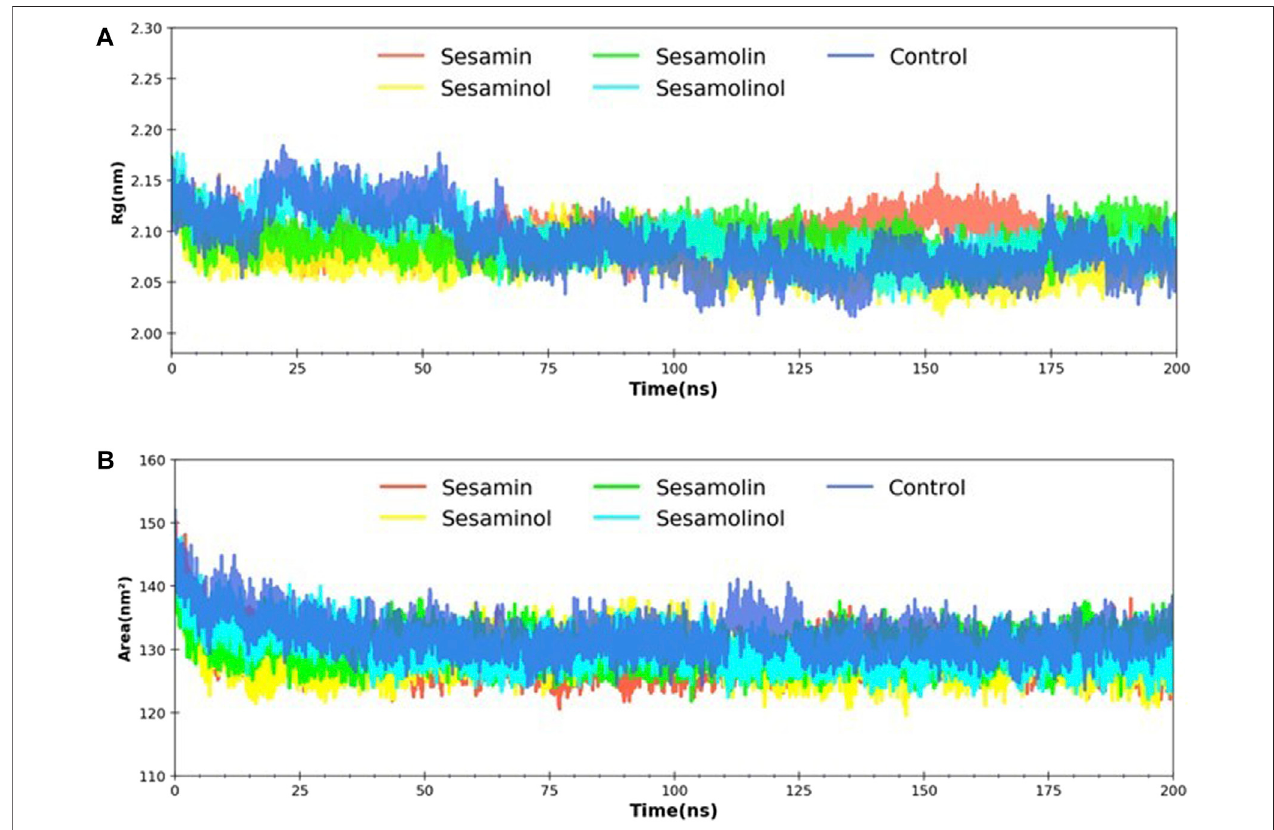
FIGURE 7 | Rg and SASA analysis. (A) Predicted Rg plot of docking complexes; and (B) SASA plot of selected complexes [M pro – sesamin complex (red), M pro – sesamolin complex (green), M pro – sesaminol complex (yellow), M pro – sesamolinol complex (cyan), and control (blue)].